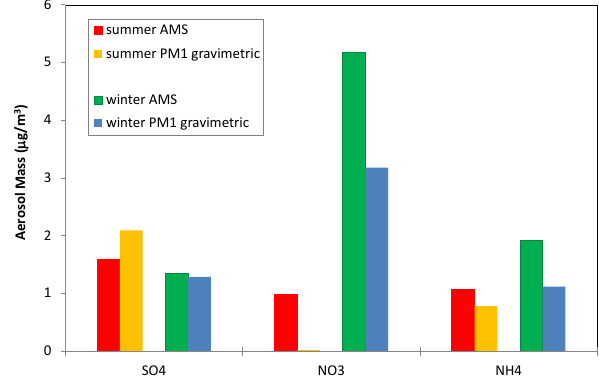
Fig. 2. Comparison of chemical speciation measurements using AMS and filters from gravimetric PM 1 sampler at Payerne,